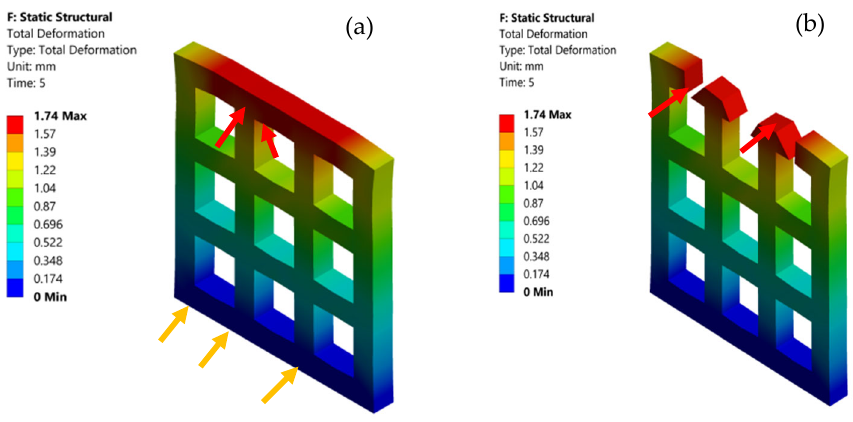
Figure 6. ( a ) Total deformation of the scaffold model and ( b ) fractured area (red arrow) of the scaffold model.